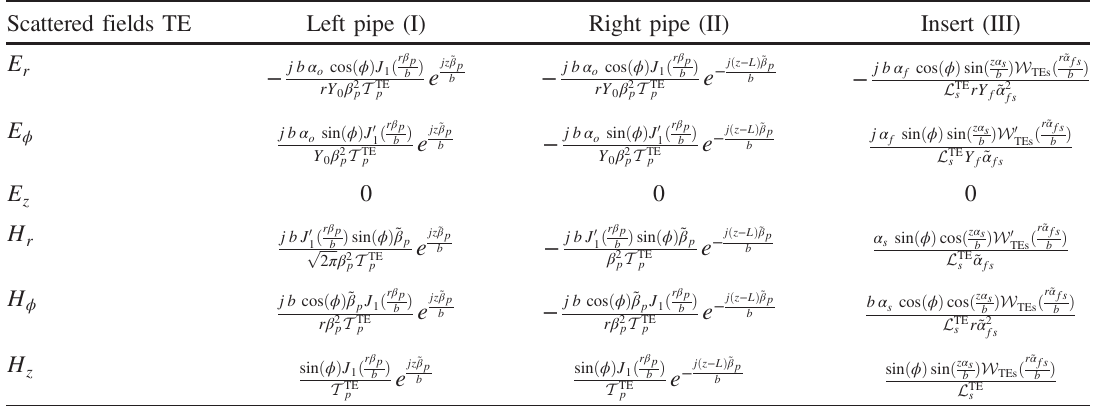
TABLE III. TE scattered field components (subdomains I – III). Scattered fields TE Left pipe (I)